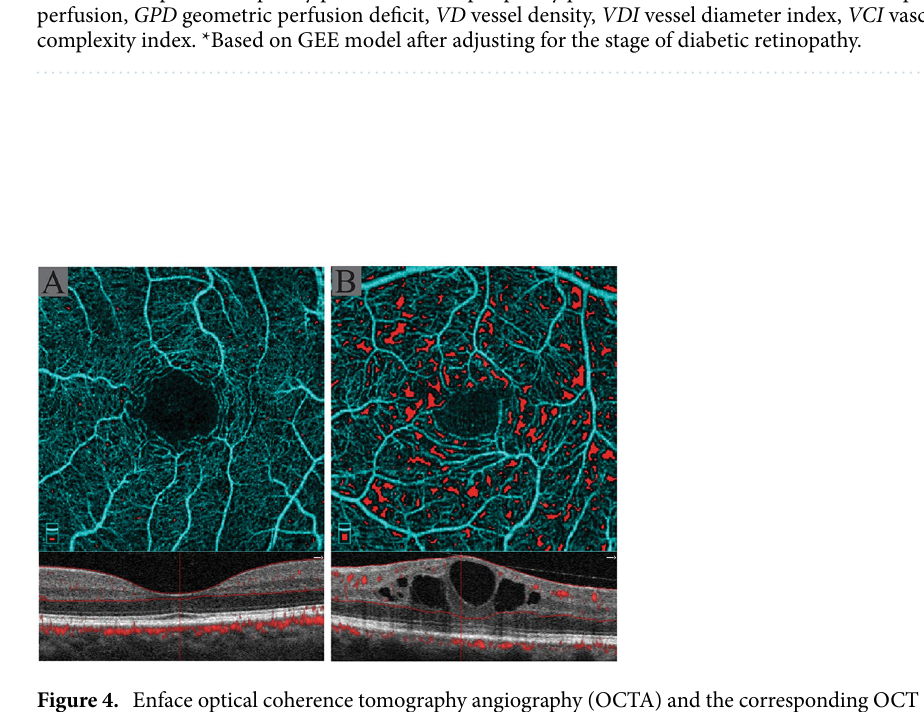
Figure 4. Enface optical coherence tomography angiography (OCTA) and the corresponding OCT B-scan image of two age-matched patients with similar stage of diabetic retinopathy showing lesser extent of capillary non-perfusion in patient without diabetic macular edema (A) in comparison to the patient with macular edema (B) . Red colors in enface images show geometric perfusion deficit (0.17% versus